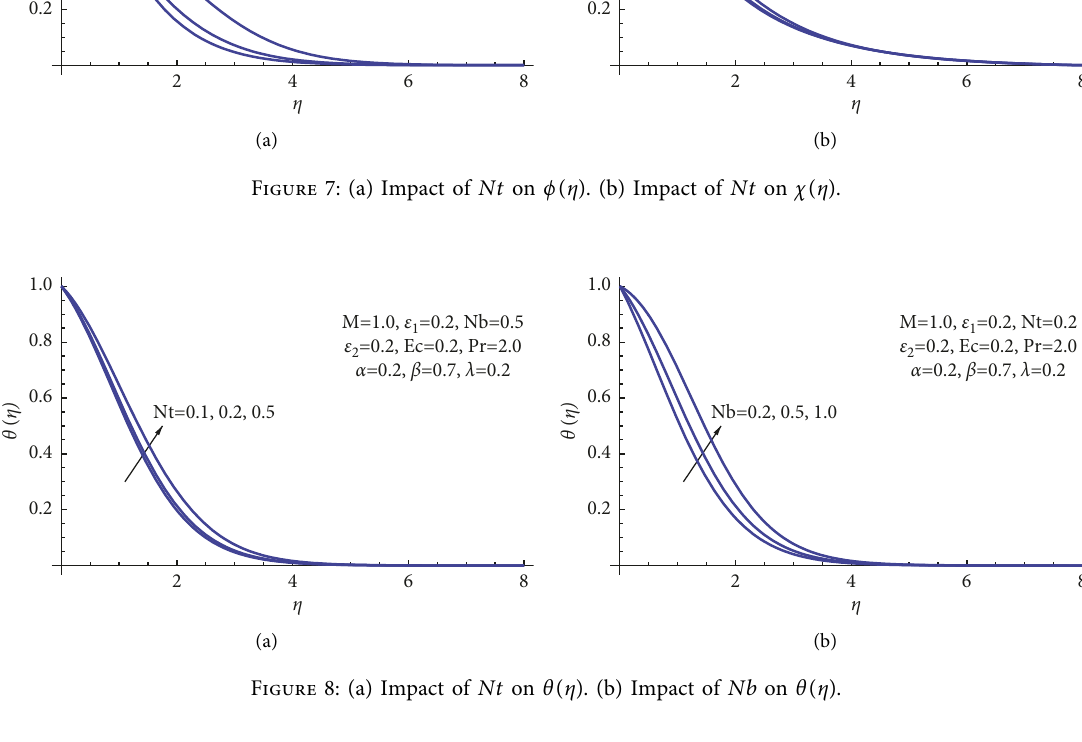
Figure 8: (a) Impact of Nt on θ ( η ) . (b) Impact of Nb on θ ( η ) .